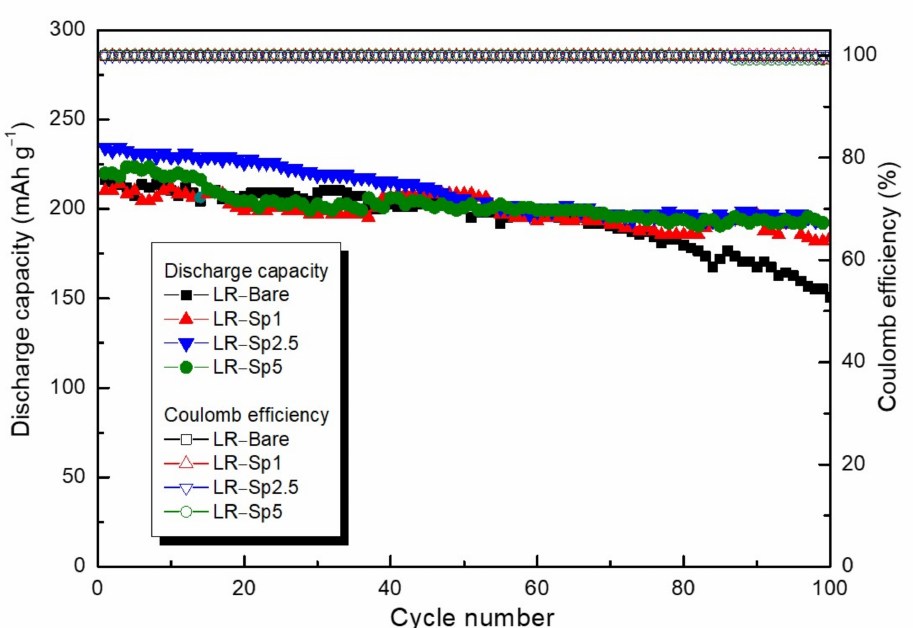
Figure 8. Cycle life performance of LR–Bare, LR–Sp1, LR–Sp2.5, and LR–Sp5 cathodes at 2–4.6 V. To explain the electrochemical properties of LR–Bare and LR–Sp2.5, electrochemical impedance spectroscopy (EIS) was operated after 25 charge–discharge cycles at 2.0–4.6 V and then in a charged state at 4.2 V. The impedance spectra shown in Figure 9 contained the bulk resistance of the electrolyte (R e ), the resistance at the contact of the composite cathode (R SEI ), the charge transfer resistance at the interface of the cathode–electrolyte (R ct ), and a line inclined at a constant angle to the real axis in the low–frequency range corresponding to Li + diffusion in the materials [5,55,58]. The R ct and lithium ion diffusion coefficient (D Li+ ) were 23.1 Ω and 2.96 × 10 − 12 cm 2 s − 1 for LR–Bare and 20.0 Ω and 3.21 × 10 − 12 cm 2 s − 1 for LR–Sp2.5, respectively. This shows that the sample with a spinel nanolayer had the fastest lithium–ion insertion and extraction kinetics at the electrolyte–electrolyte interface.